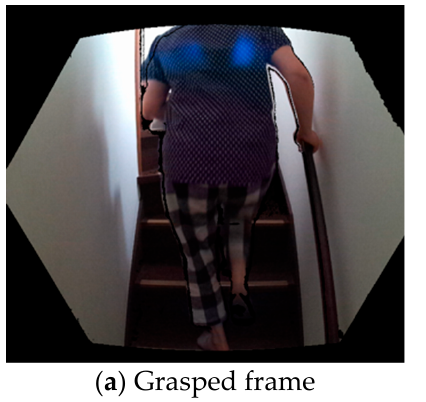
Figure 3. Labeling of the “grasp” or “not grasped” frame.